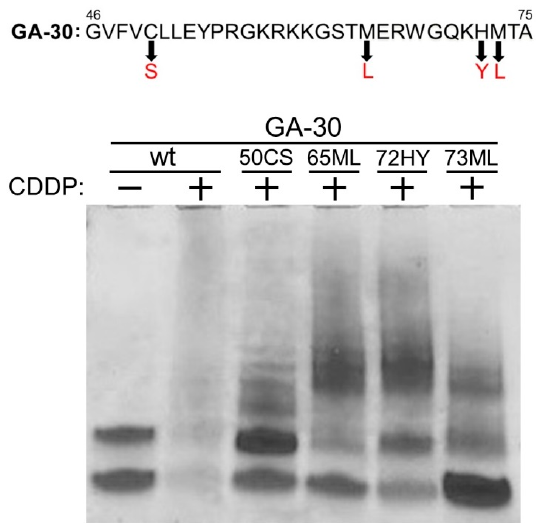
Figure 3. Binding of CDDP to four amino acid residues in the GA-30 domain. The four commercially synthesized GA-30 peptides individually with single amino acid substitution, 50CS (Cys → Ser), 65ML (Met → Leu), 72HY (His → Tyr) and 73ML (Met → Leu), were tested for binding to CDDP. Ten micrograms of the wild type and the mutant GA-30 peptides were separately incubated with 1 mM CDDP at room temperature overnight. The reactions were analyzed by Tris-Tricine SDS-PAGE and Coomassie blue staining.